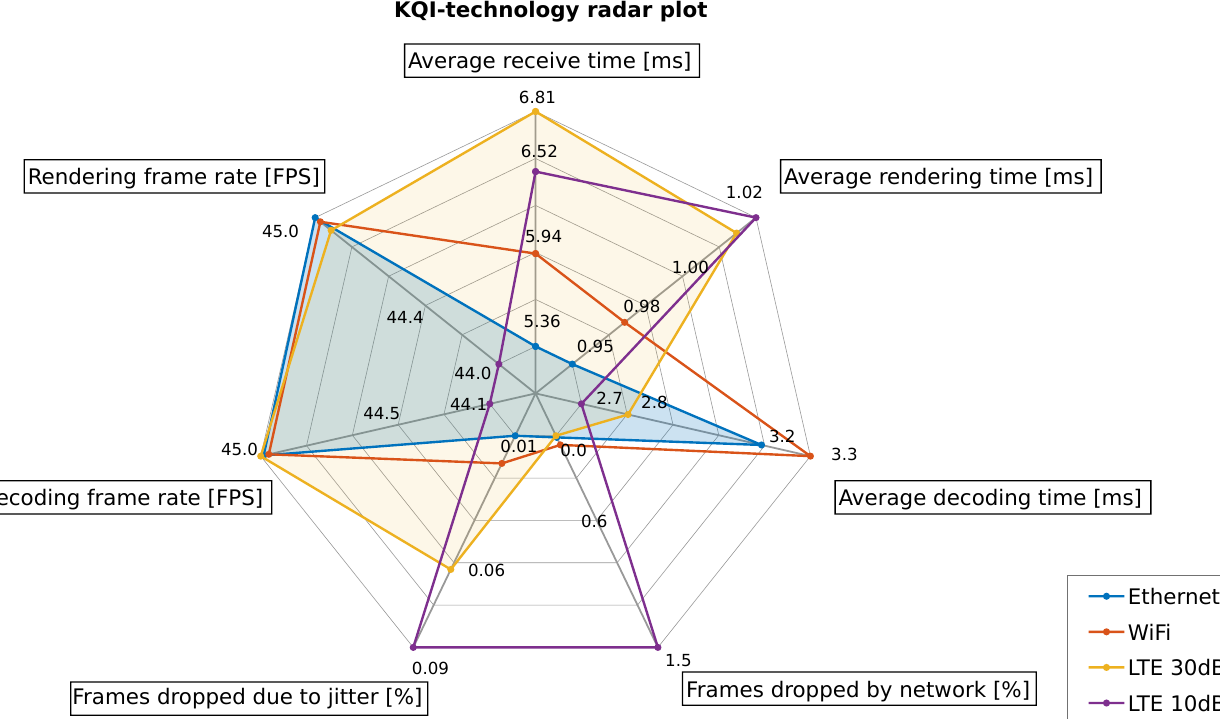
Figure 13. KQI performance for the assessed